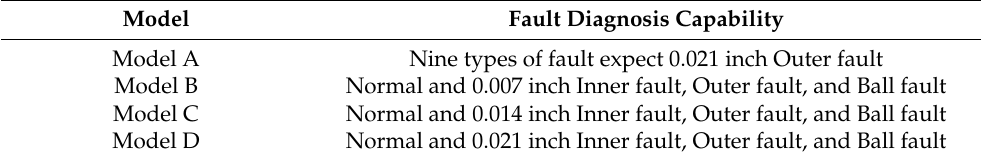
Table 4. Models with different fault diagnosis capability.